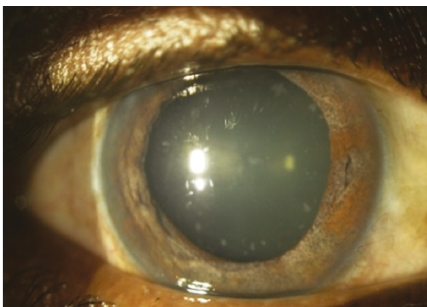
Figure 2: Iris atrophic Patches and 6mm pupil.